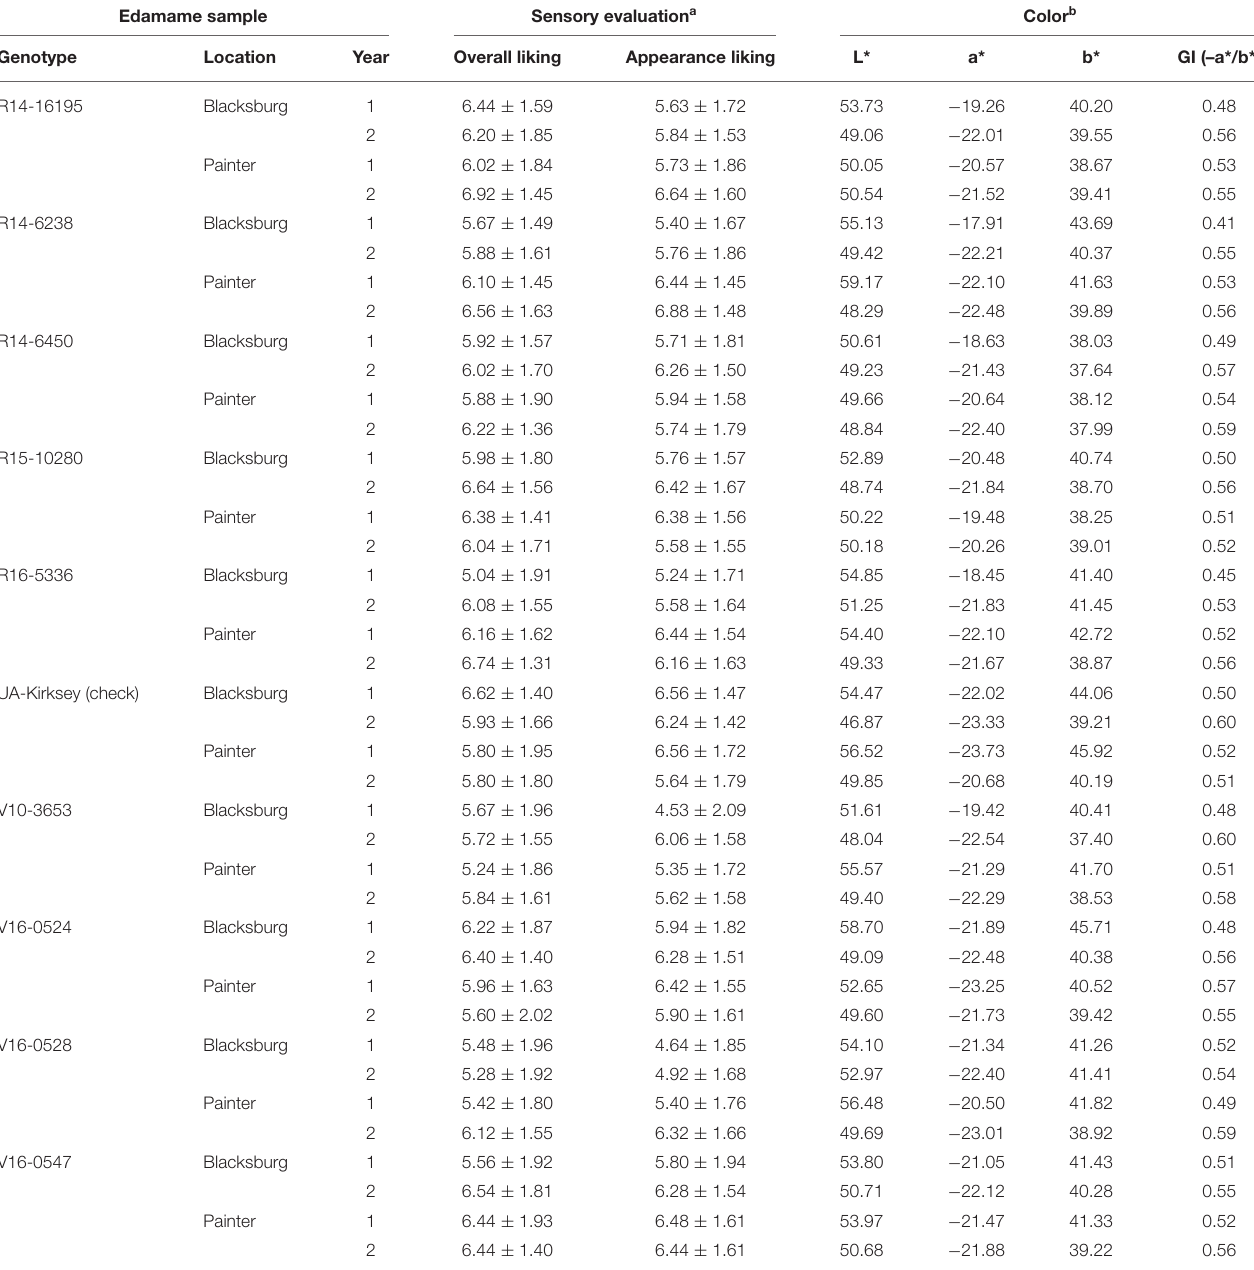
TABLE 1 | Overall liking, appearance liking, and color characteristics of edamame genotypes. Edamame